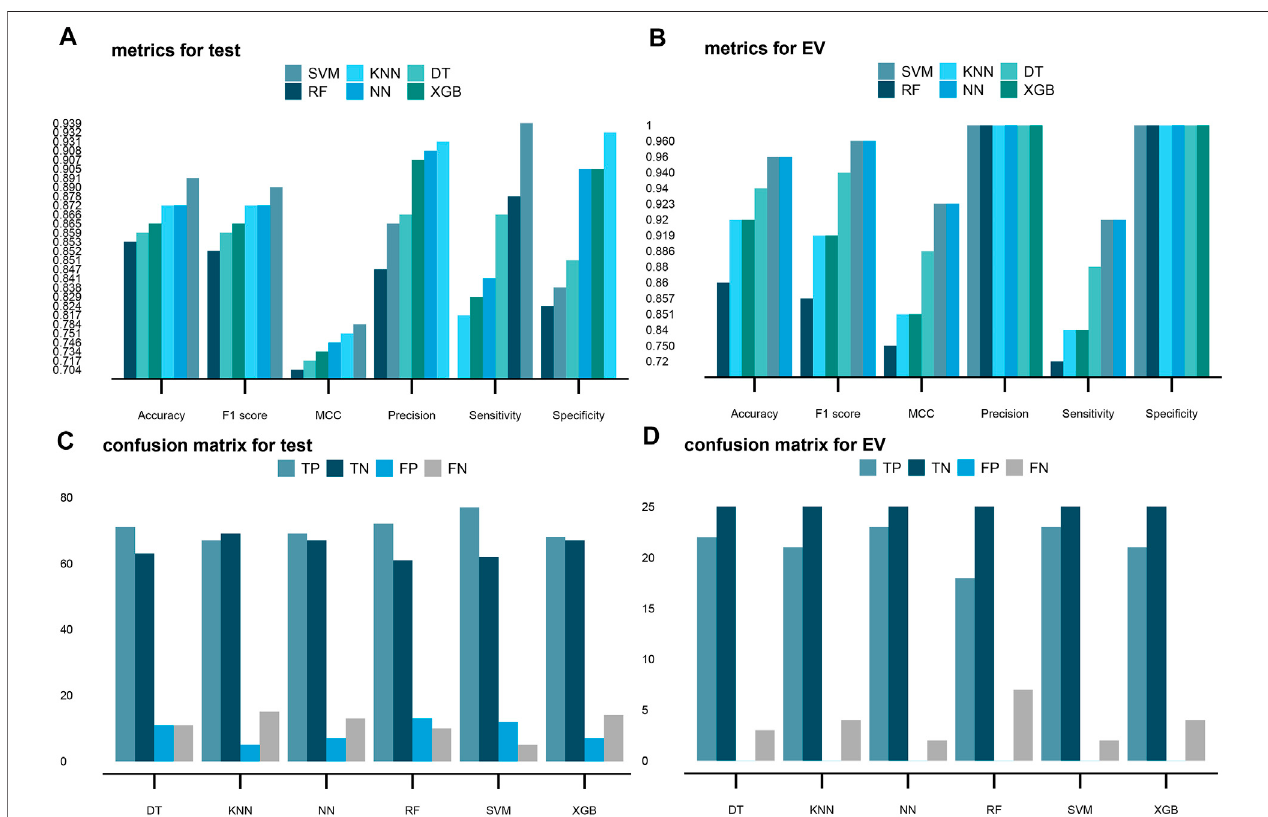
FIGURE 6 | Performance of the six supervised machine learning models on the test and EV sets. Hyperparameters of all six models are tuned with the GridSearchCV method,accordingtothe “ MCC ” metric,andthen,thesixbestmodelswerechosenafterexplorationofthewholegrid.PredictionsonthetestandEVsetsaremadewiththebest models. Six models used in this study are support vector machine (SVM), k-nearest neighbors (KNN), decision tree (DT), random forest (RF), neural network (NN), and eXtreme GradientBoosting(XGB)inorder. (A,B) Scoresofaccuracy,F1score,MCC,precision,sensitivity,andspeci fi cityinthesixmodelsonthetestandvaliddatasets,respectively. (C,D) Four terms of the confusion matrix (TP, TN, FP, and FN) in the six models on the test and valid datasets, respectively.